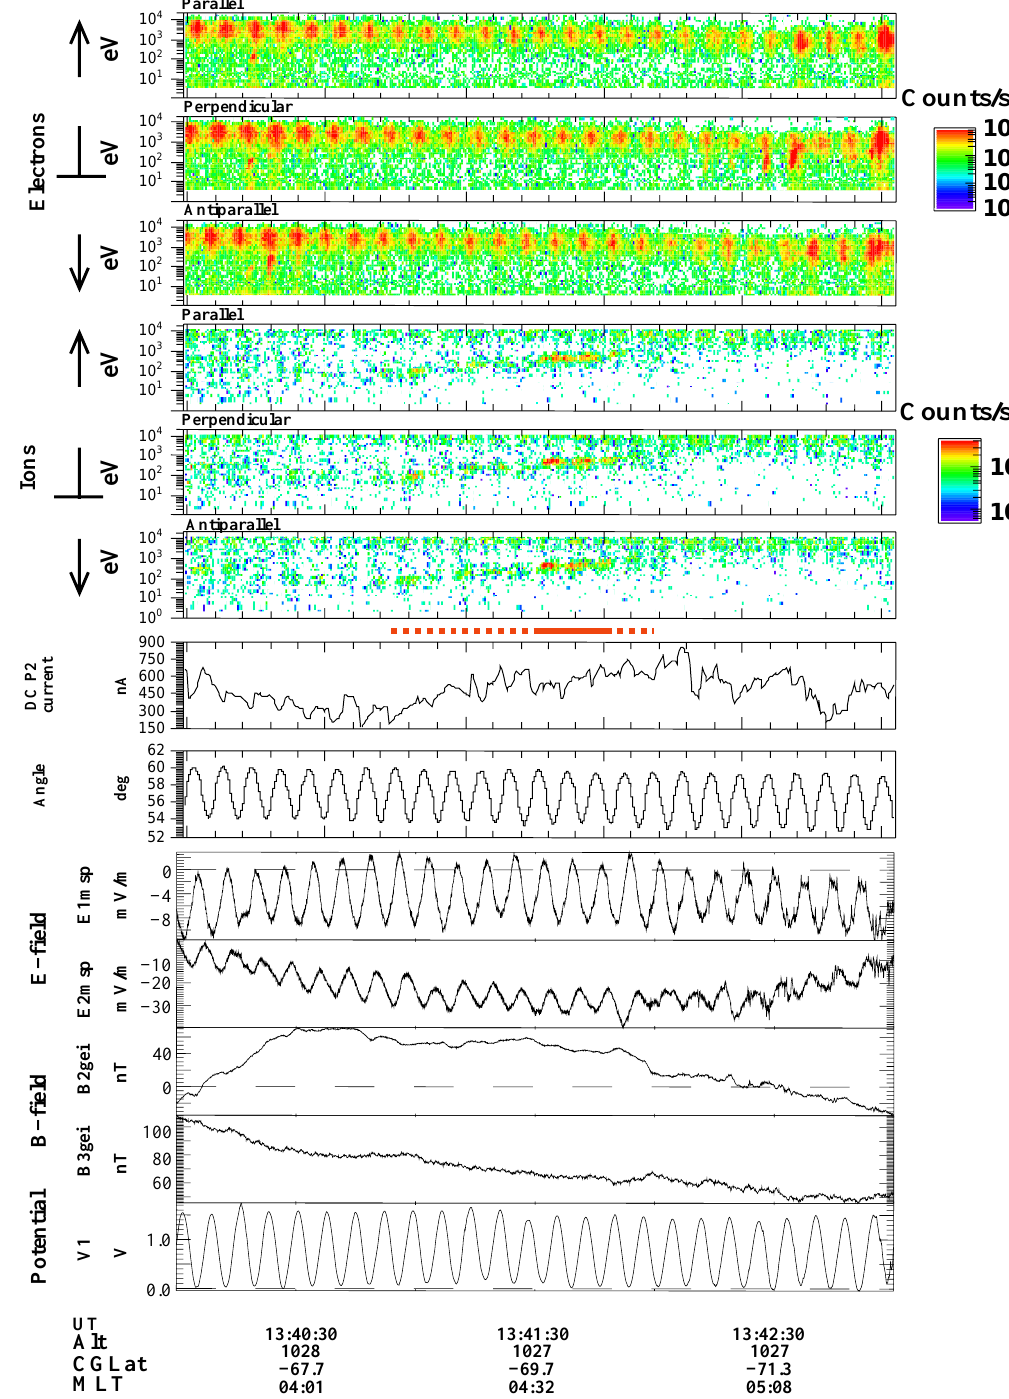
Fig. 2. Astrid-2 data for 12 July 1999 on the southern hemisphere. The data format is the same as Fig. 1. A distinct ion cloud (marked by red line) is observed inside the CPS